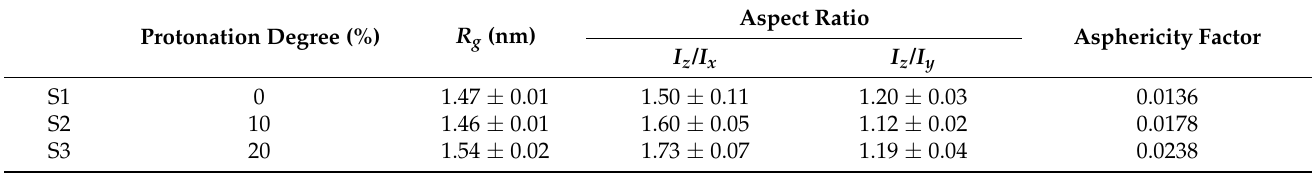
Table 4. Mean values of the radii of gyration R g , aspect ratio, and asphericity factor for G4PAMAM dendrimers at various protonation